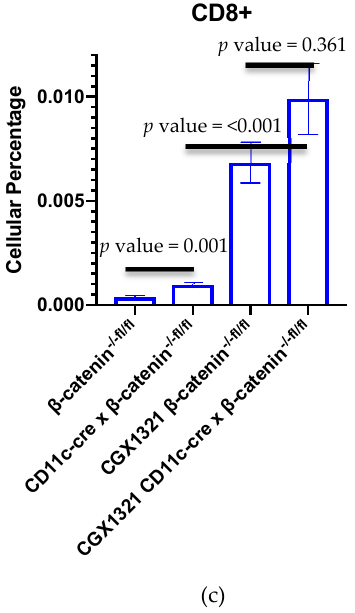
Figure 6. Inhibition of β –catenin signaling in dendritic cells decreases tumor burden. ( a ) Increased Wnt/ β –catenin signaling is thought to increase IL-10 and IL-12 production and increase the regulatory state of DCs. The absence of intrinsic DC β –catenin may promote antigen priming of CD8 + T cells [36]. ( b ) Omentum weight decreased with loss of β –catenin in CD11c-cre x β -catenin -/-fl/fl mice. Treatment with CGX1321 further increased this difference. ( c ) CD8 + T cells increased in the tumor microenvironment in CD11c-cre x β -catenin -/-fl/fl mice with ID8 tumor challenge, a finding that was further exaggerated with CGX1321 treatment.